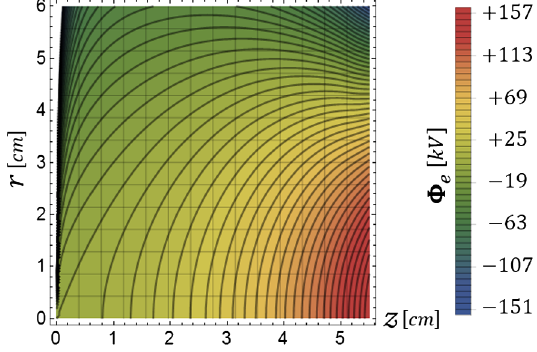
FIG. 4. The equipotential surfaces calculated from series expansion of Φ ð r; z Þ in terms of Φ ð 0 ; z Þ and its derivatives.